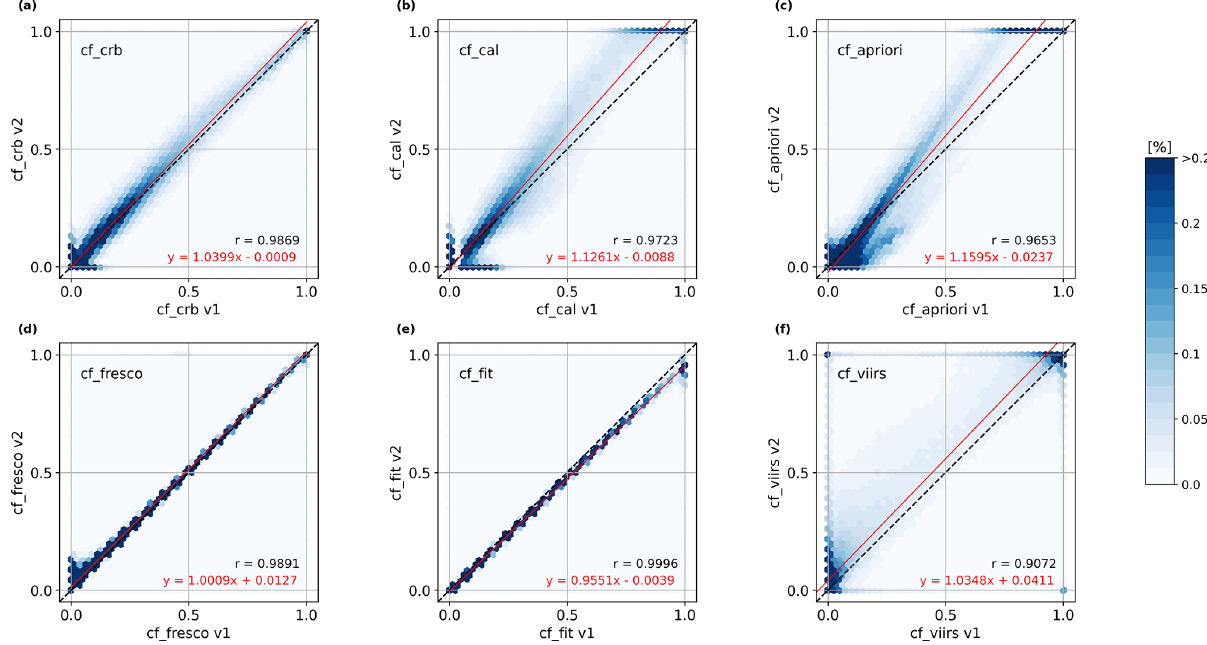
Figure A1. Density histograms between the version 1 and version 2 cloud fractions from (a) ROCINN CRB, (b) ROCINN CAL, (c) OCRA a priori, (d) FRESCO, (e) the NO 2 fitting window, and (f) VIIRS for Africa and the summer day (30 June 2018).